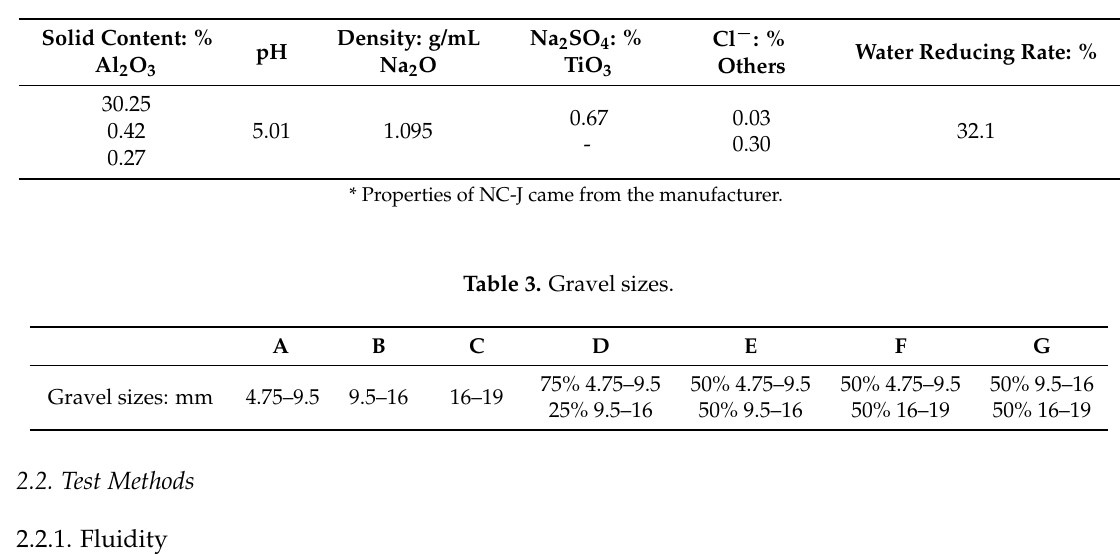
Table 2. Properties of Polycarboxylate Superplasticizer (SP).